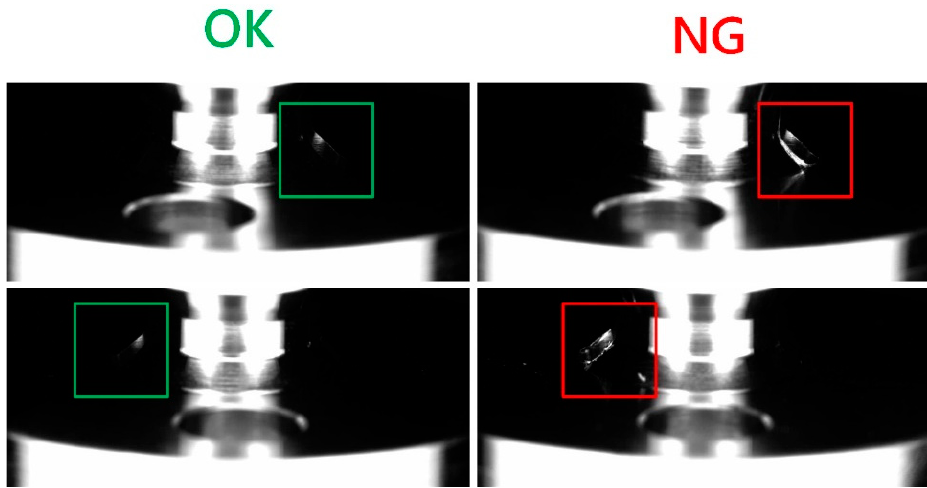
Figure 10. Original OK ( left ) and NG defect ( right ) image.